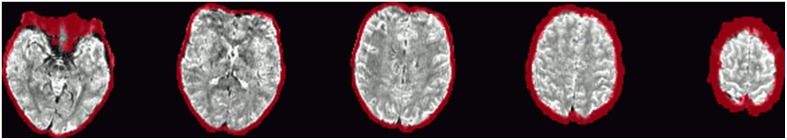
Example of the definition of “brain edge” voxels, marked in red, and defined by erosion of the brain mask by a 5 × 5 × 5-voxel kernel.